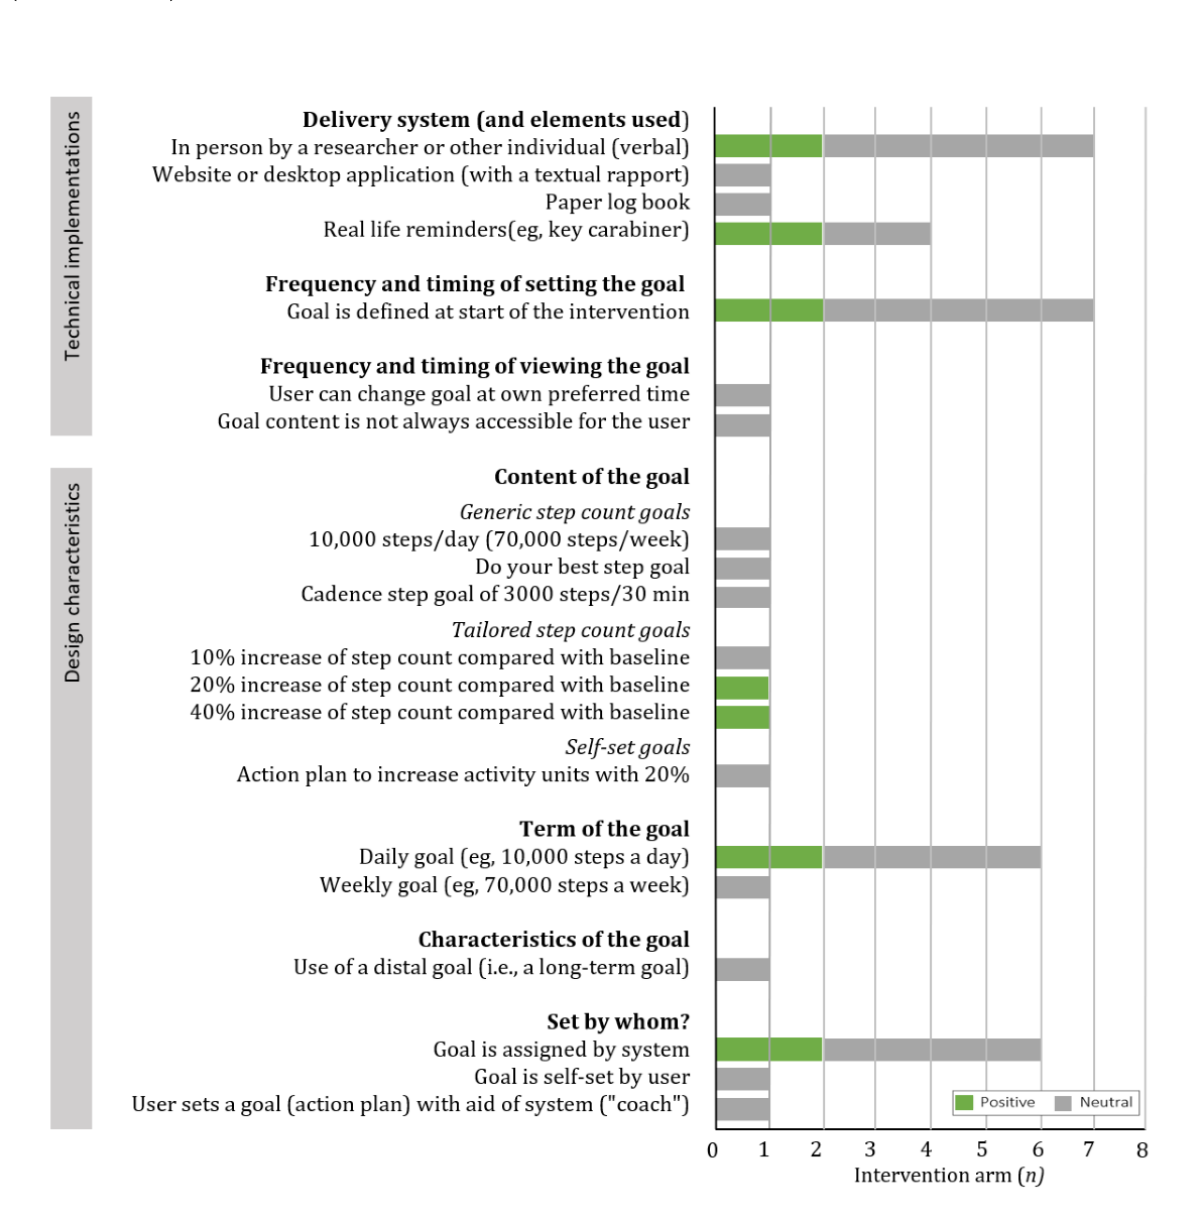
Figure 1. The effectiveness of the technical implementations and design characteristics of goal setting compared with receiving no goals in 7 intervention arms (3 different